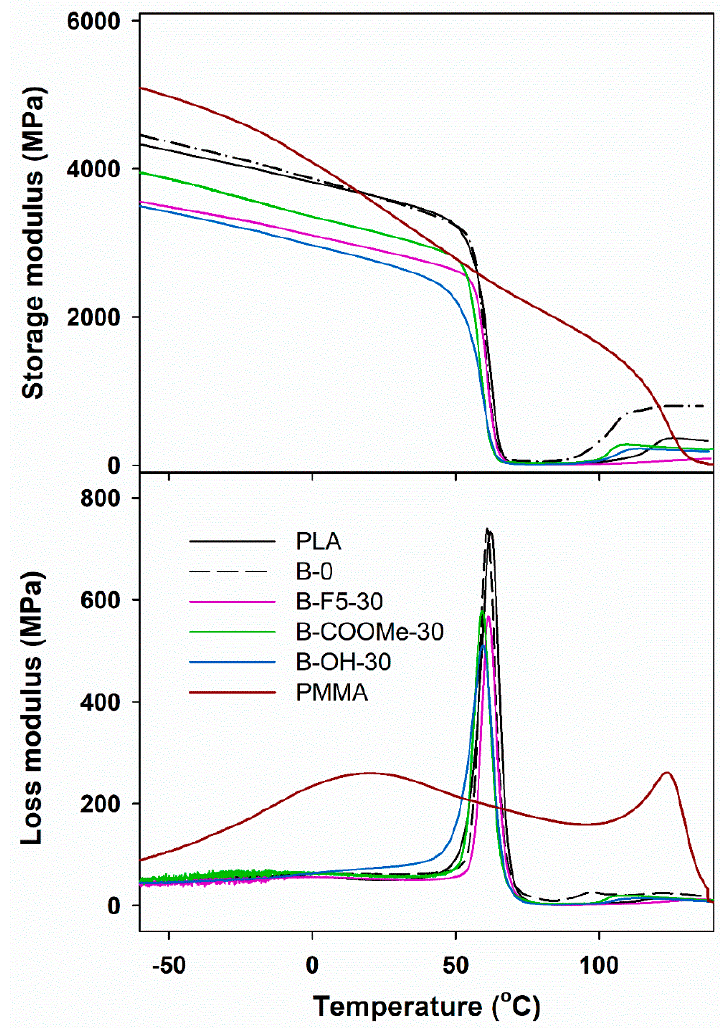
Figure 1. Storage modulus ( E’ ) and loss modulus ( E” ) of neat polylactide (PLA), poly(methyl methacrylate (PMMA), PLA/PMMA blend (B-0) and selected LPSQ-R modified blends vs. temper- ature.